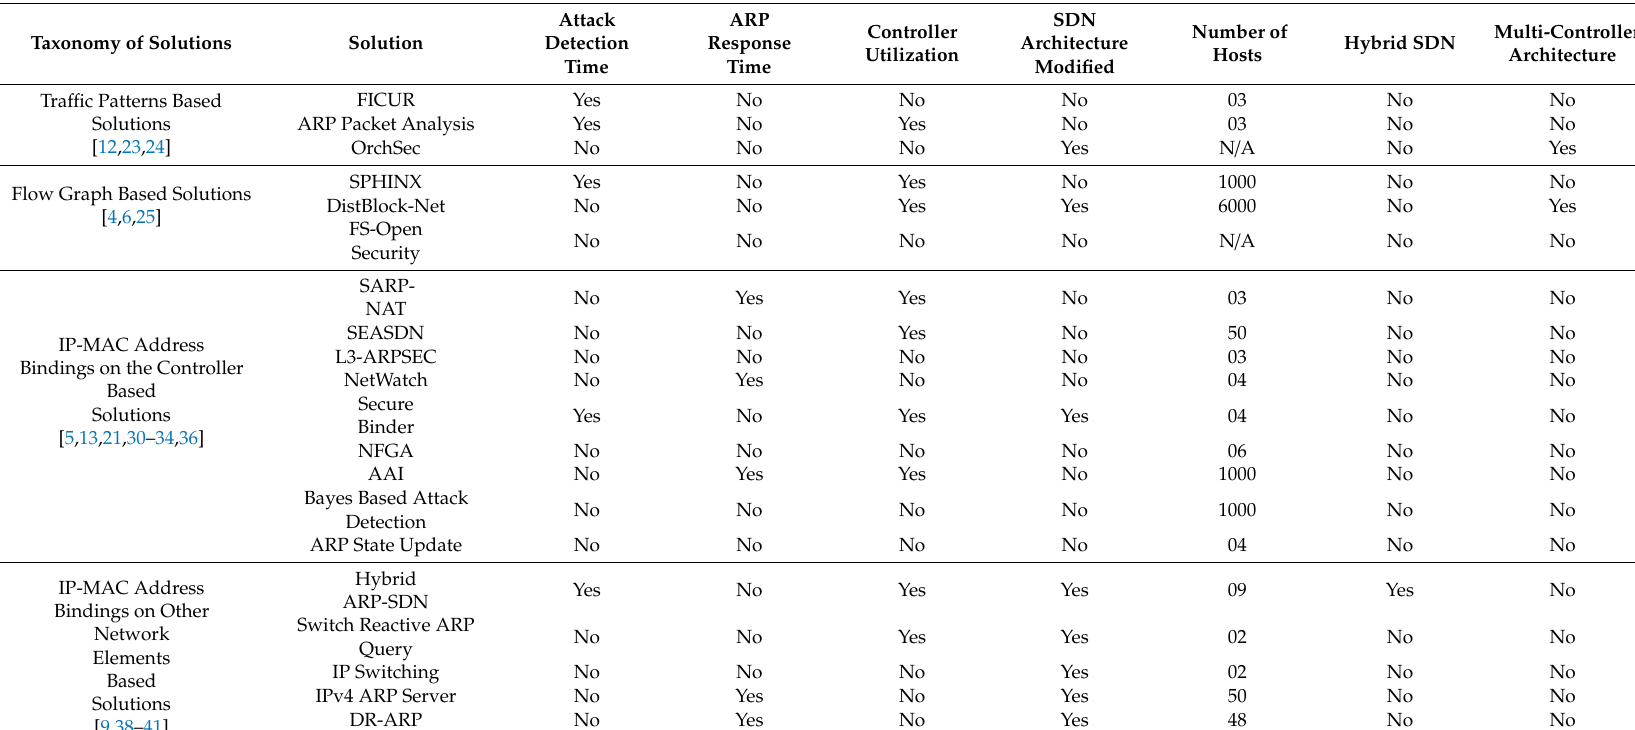
Table 5. Comparison of Various